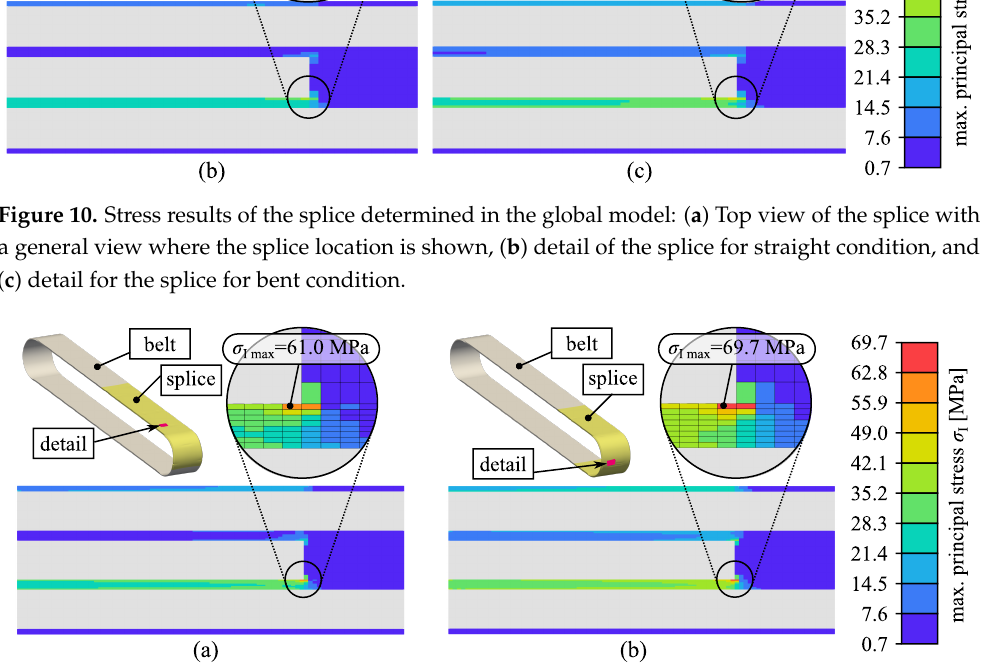
Figure 11. Stress results of the splice determined in the submodel: ( a ) Detail of the splice for straight condition, and ( b ) detail for the splice for bent condition.